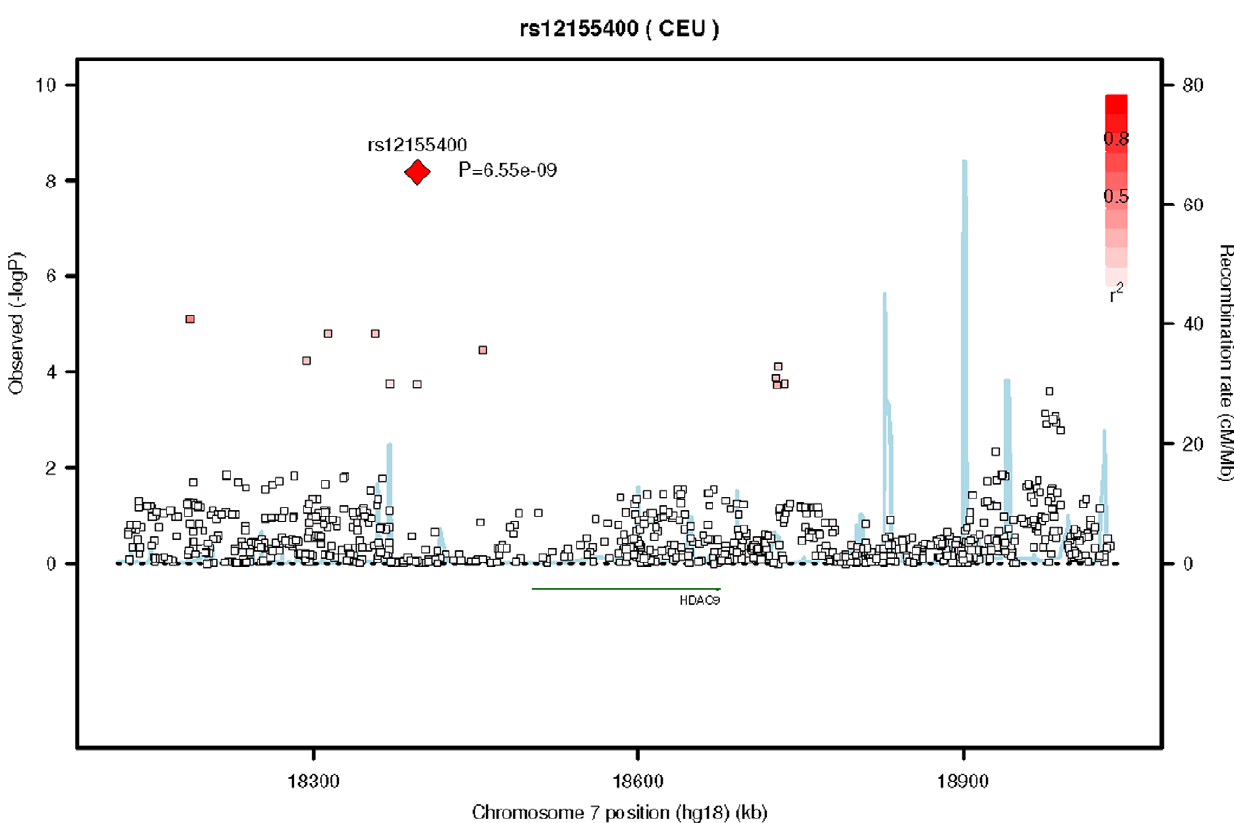
Figure 1. Regional association plot of SNP rs12155400 on chromosome 7 for Caucasians. This figure is the regional association plot of SNP rs12155400 on chromosome 7 that reached genome-wide significance in the meta-analysis of GWAS results in participants of European ancestry without diabetes or hypertension. The lead and surrounding SNPs are color coded according to the pair-wise linkage disequilibrium (LD) with the lead SNP (presented as a diamond) on a scale of r 2 from 0 to 1. Estimated recombination rates reflect the local LD structure in the 500 kb buffer around the index SNP and plotted based on values from HapMap II Centre d’Etude du Polymorphisme Humain collection samples from a Utah (CEU) population.